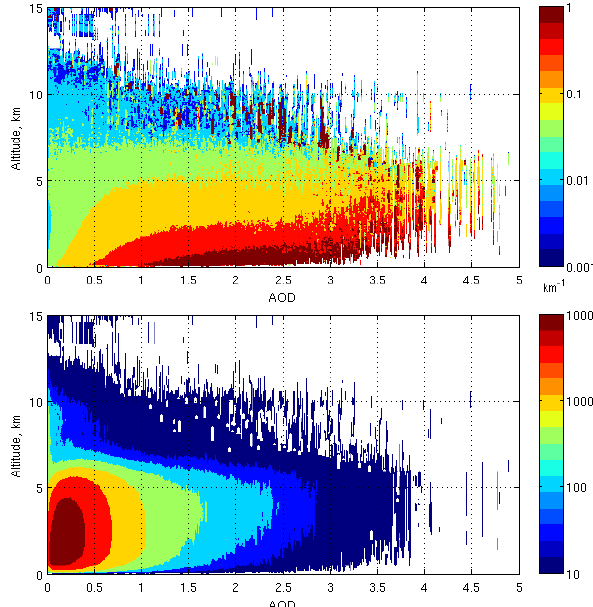
Figure 1. Extinction profile of the dust at 532nm (top panel) and corresponding number of samples (bottom panel) as a function of column AOD, derived from CALIPSO Lidar Level 2 aerosol profile product. Extinction profiles were screened over the Arabian Penin- sula (land) and combined into column AOD bins with 0.01 step. Val- ues, averaged within each bin, are color-coded using the log